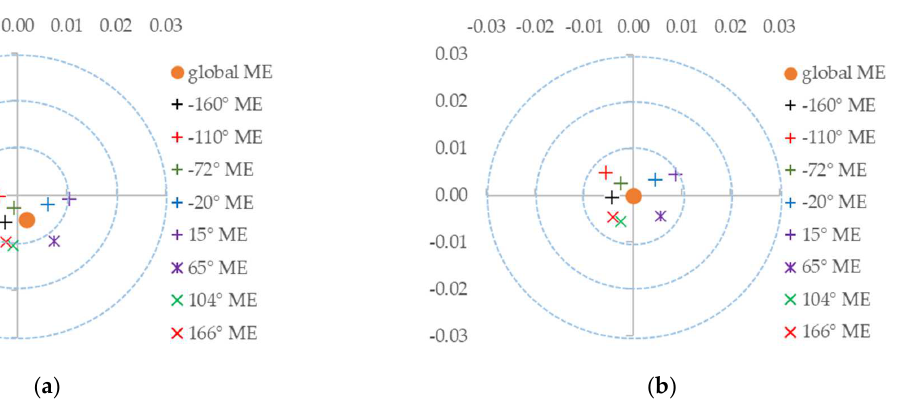
Figure 24. Mean error on the X and Y coordinates of the GCP positions when using the P4-RTK antenna and the D-RTK2 station on the ground: ( a ) direct results; ( b ) results after centering on the global mean error.